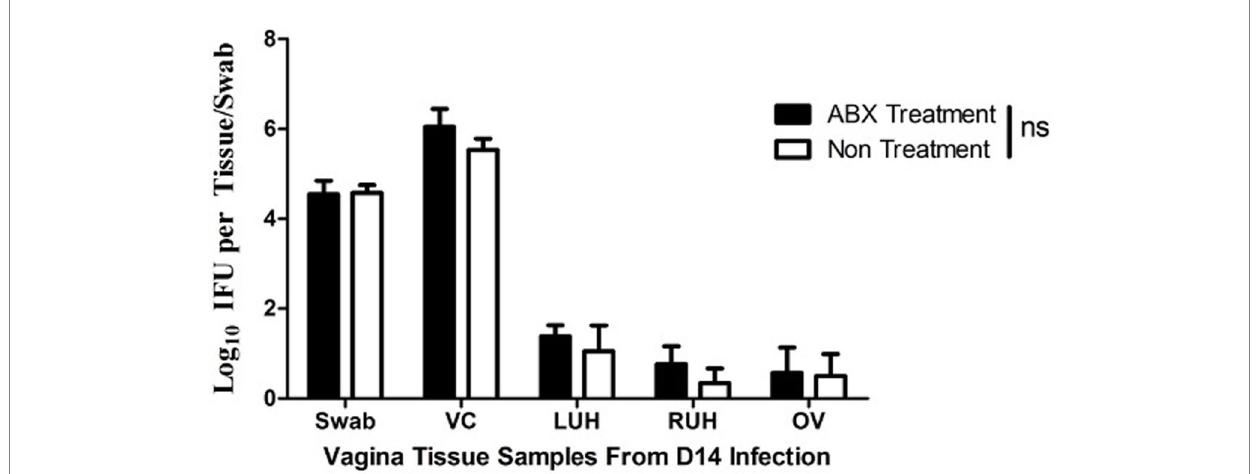
FIGURE 3 Oral antibiotics treatment fails to alter C. muridarum ascension to the upper genital tract. Female DBA2/J mice without (Non, n = 5) or with (ABX, n = 5) oral antibiotics treatment for 21 days were intravaginally inoculated with C. muridarum. The oral ABX was maintained in drinking water throughout the experiment. On day 14 after the intravaginal inoculation, all mice were sacrificed for titrating live organisms recovered from different regions of the genital tract including vagina/cervix (VC), left uterine horn (LU), right uterine horn (RU) and oviduct/ovary (RO) as shown along X-axis. The live organisms recovered were expressed as Log10 IFUs as shown along Y -axis. Note that live C. muridarum organisms were similarly detected in uterine horn and oviduct tissues of all mice regardless of the oral antibiotics’ treatment ( p > 0.05, Wilcoxon for comparing IFUs from individual tissues between the two groups of mice).